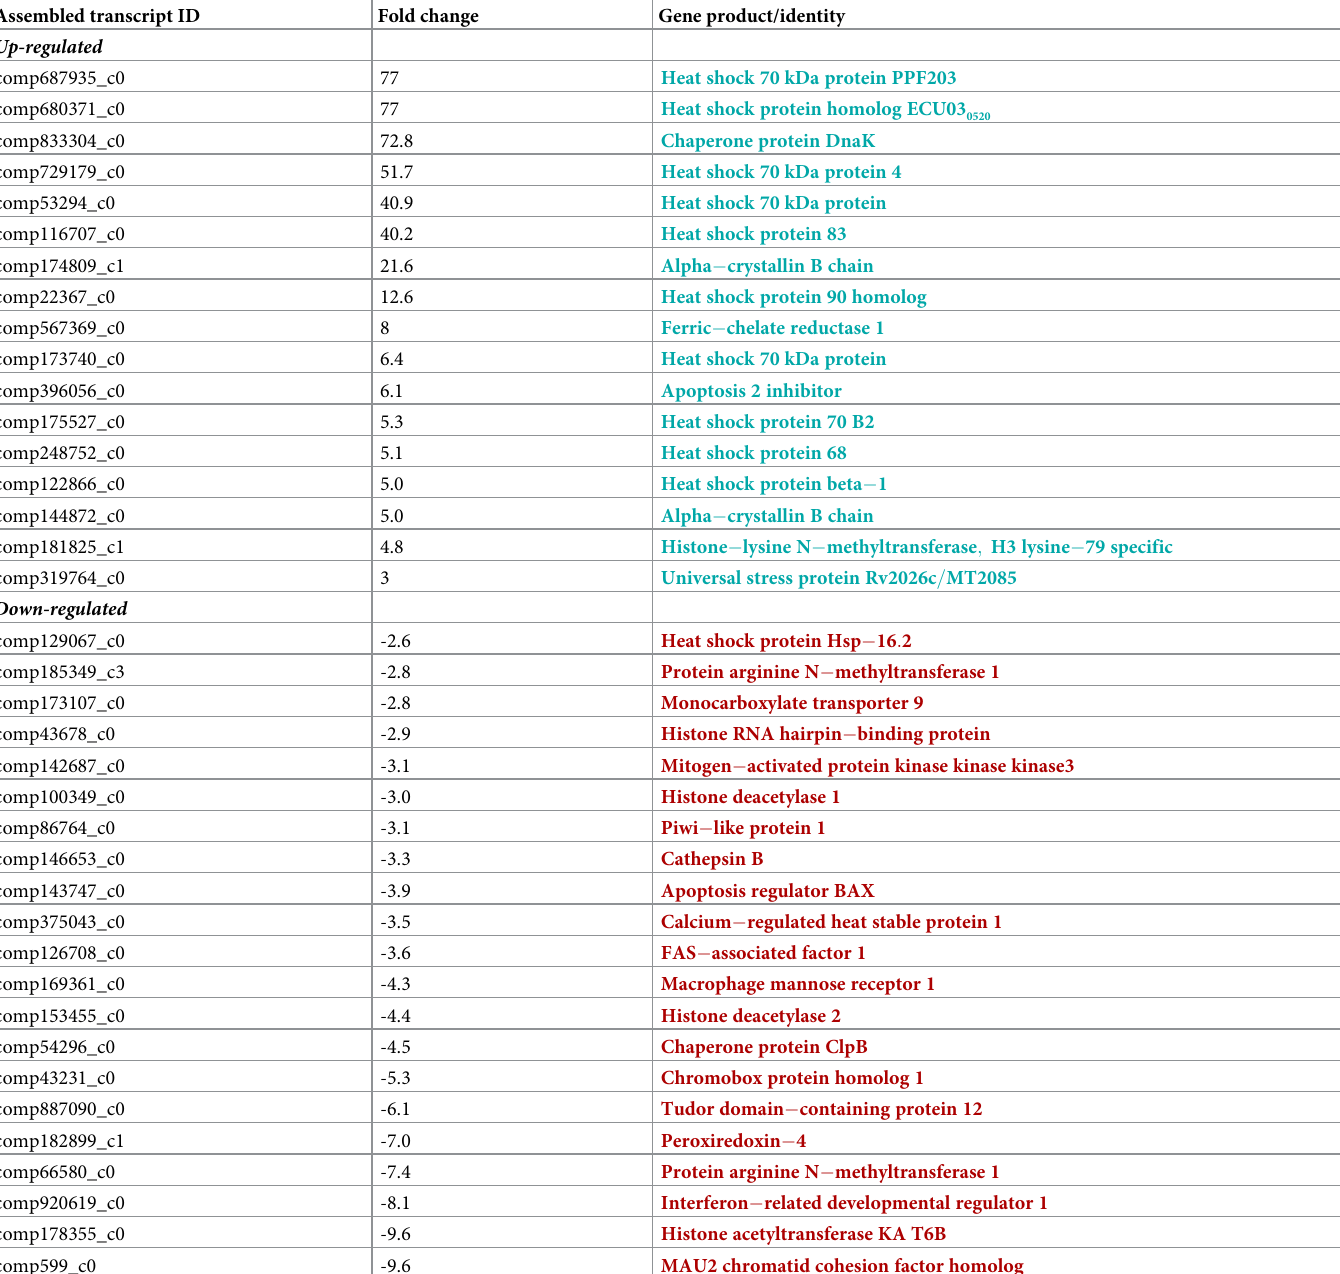
Table 1. Differential expression of downregulated (green) and upregulated (red) transcripts from RNA-seq data of B . glabrata BS-90 snail stocks cultured either at permissive (32˚C) or non-permissive (25˚C) temperature. Assembled transcript ID Fold change Gene